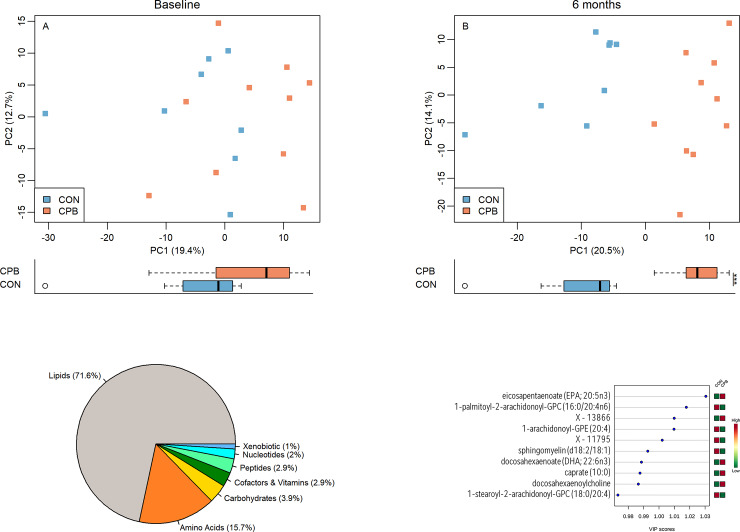
(A, B) Principal component analysis (PCA) based on diet effects at baseline (A) and 6 months (B). The percentages of data variation explained by the first two principal components, PC1 and PC2, are indicated on the x and y axes respectively. Distributions of samples along PC1 by diets were plotted below each PCA plot. Blue squares represent CON diet while orange ones represent CPB diet. *P < 0.05; **P < 0.01; ***P < 0.001. (C) Pie chart shows percentage of each metabolite class. (D) Partial least squares discriminant analysis (PLS-DA) identified ten metabolites with the highest Variable Importance in Projection (VIP) scores, which indicates discriminant power between groups.